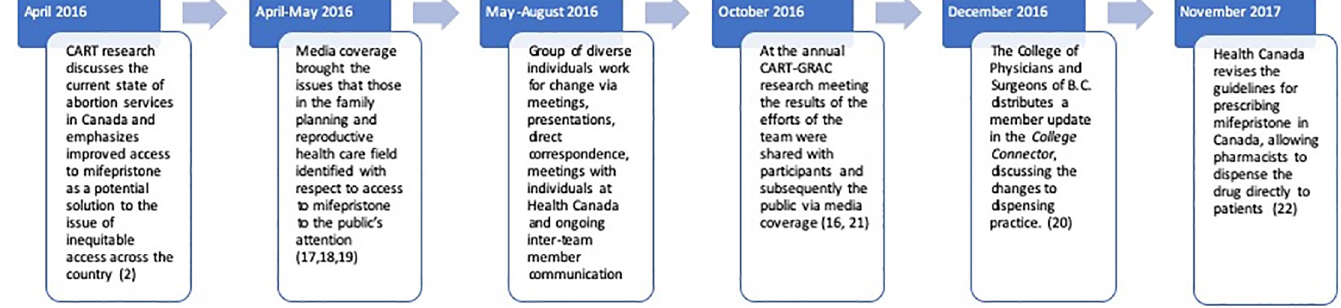
Fig 2. Timeline of policy change.